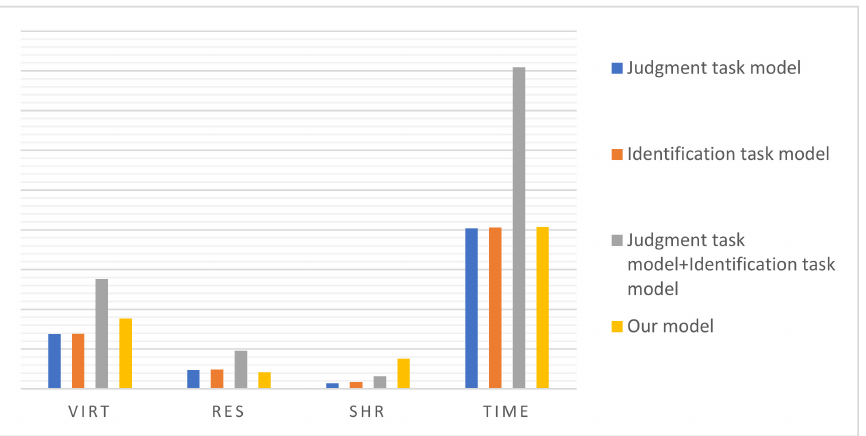
Figure 18. Resource usage comparison. Virtual memory usage (VIRT) indicates the total virtual memory applied for by a process, including the libraries, codes, and data used by the process,